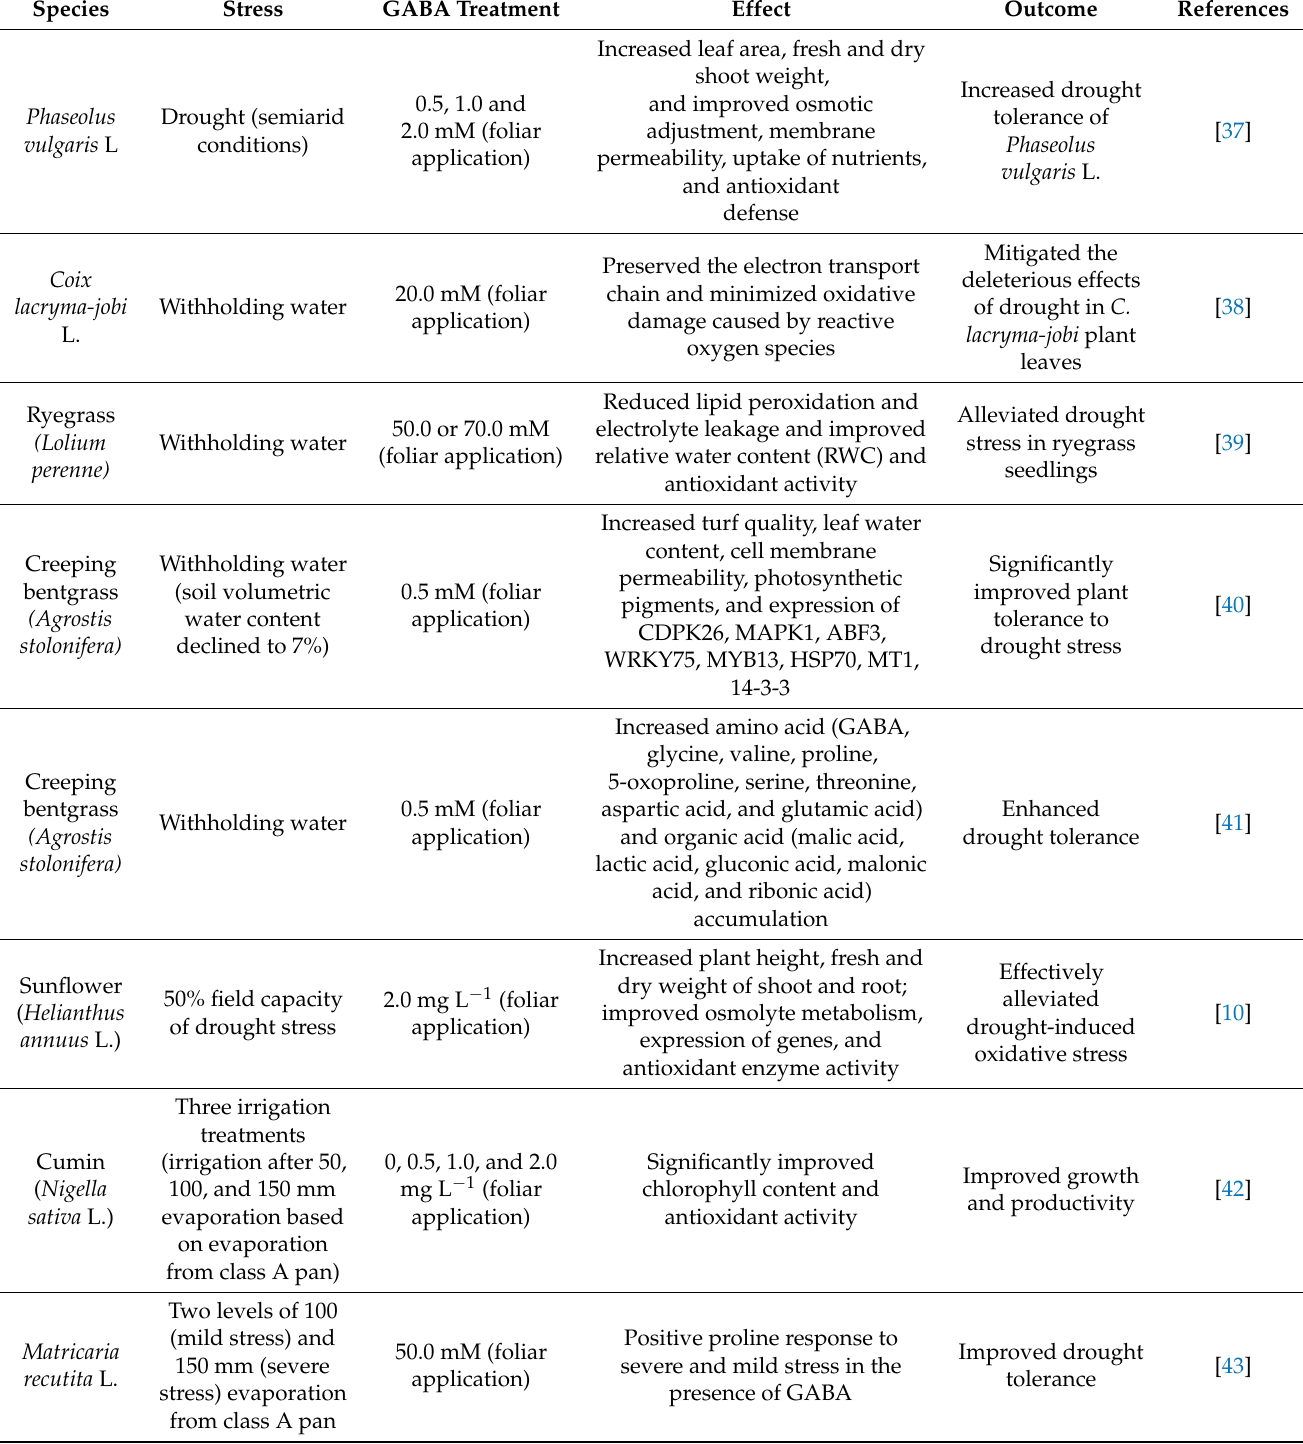
Table 1. GABA-mediated growth, photosynthetic traits, antioxidant defense, and osmoregulation in a wide range of plant species under drought